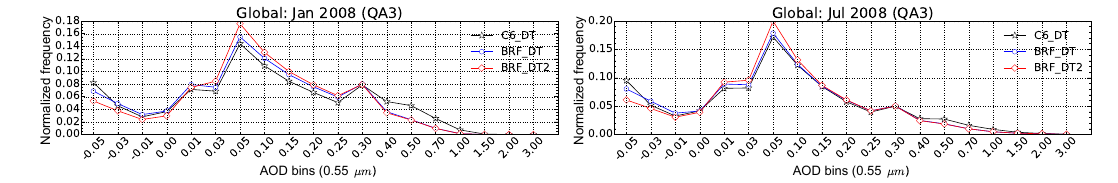
Figure 10. Histograms for the global land DT AOD (at 0.55µm) from Aqua for 2 months. Other symbols are similar to Fig. 9.